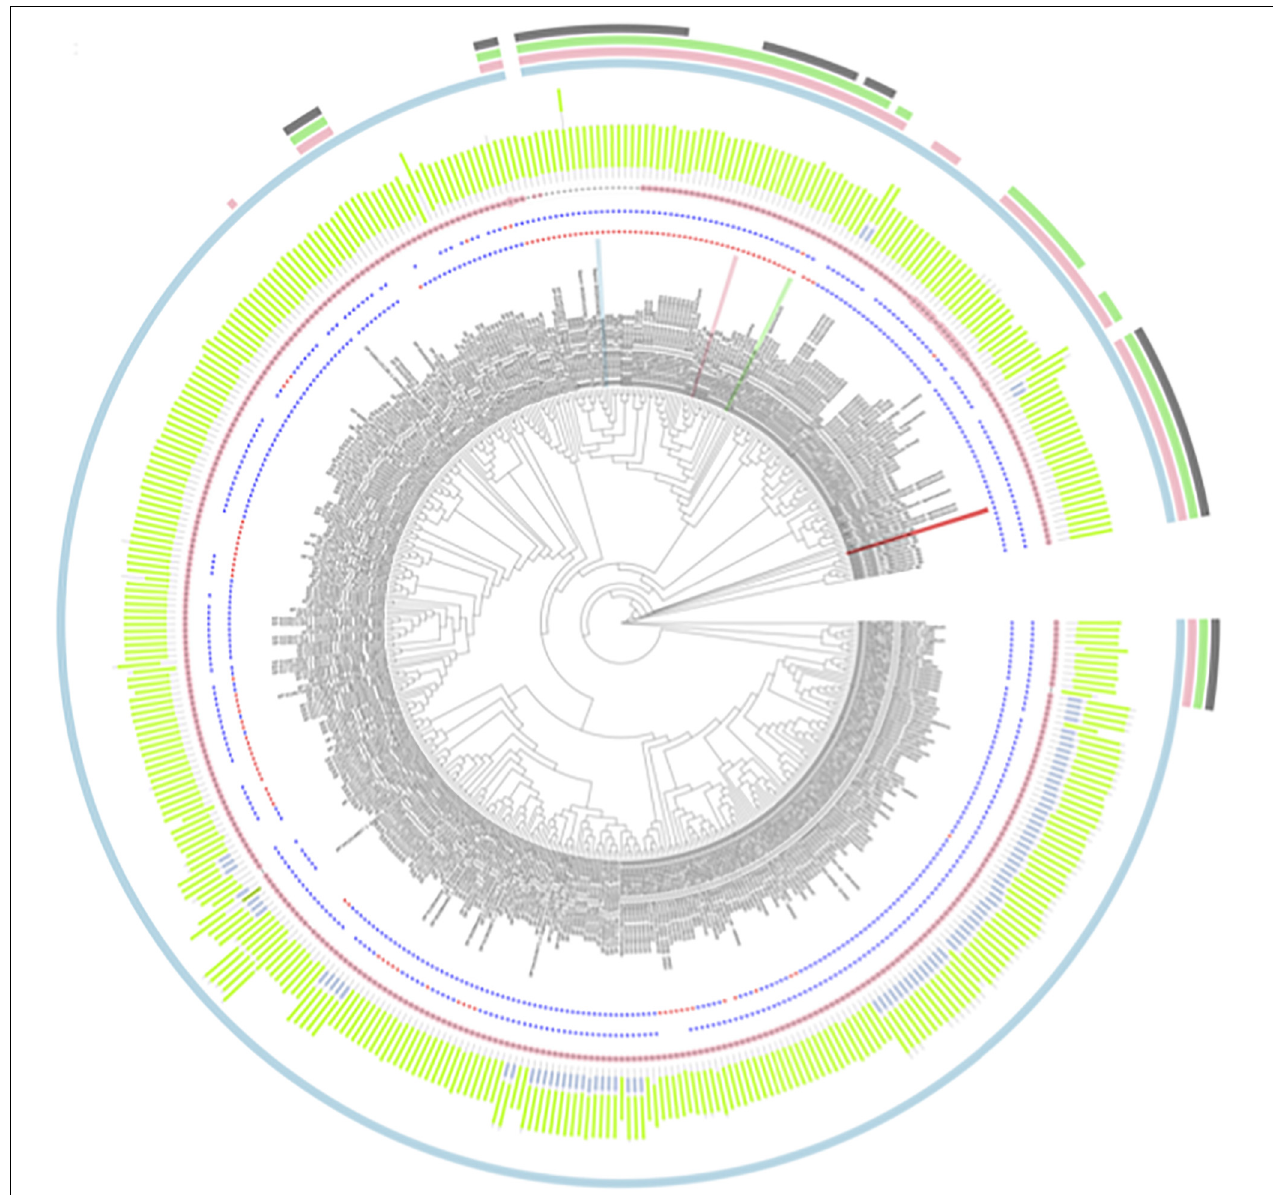
FIGURE 1 | Phylogenetic analysis for 436 PR-4 proteins found in the genome annotation from 106 Embryophyta species. Labels colored as red, blue, green and pink highlight the positions of SUGARWINS 1, 2, 3, and 4, respectively. The first- and second-star rings represent the amino acid composition in the positions H11 and H111, respectively, with blue and red stars representing histidine and asparagine residues, respectively. The pink dot plots represent the number of additional residues in relation to SUGARWIN2 in the loop corresponding to the SUGARWIN1 variable loop, the larger the circle, the greater the number of additional amino acids. In the next circle, green and blue bars represent the positions of the Barwin and chitin recognition domains, respectively, according to PFAM results. The set of four outermost circles shows the sequences from the taxonomic groups: Magnoliopsida (light blue), Liliopsida (pink), Poales (light green), and PACMAD